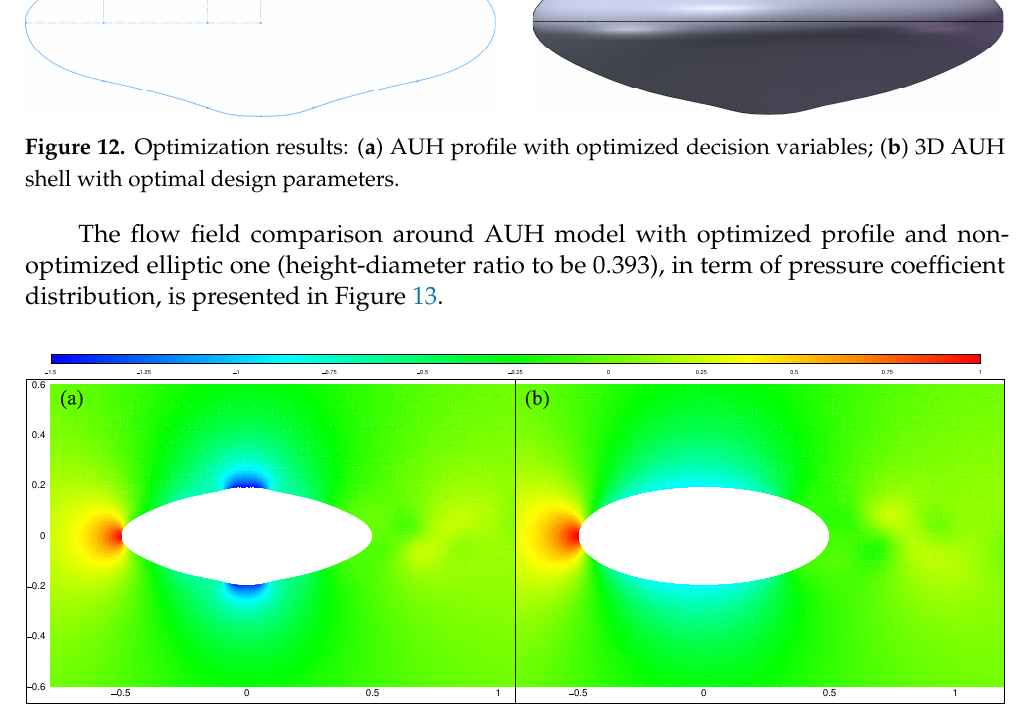
Figure 13. Snapshot of pressure contour around AUH with ( a ) optimized profile; ( b ) non-optimized elliptic curve. (Both x and y coordinate is nodimensionalized with AUH’s diameter D